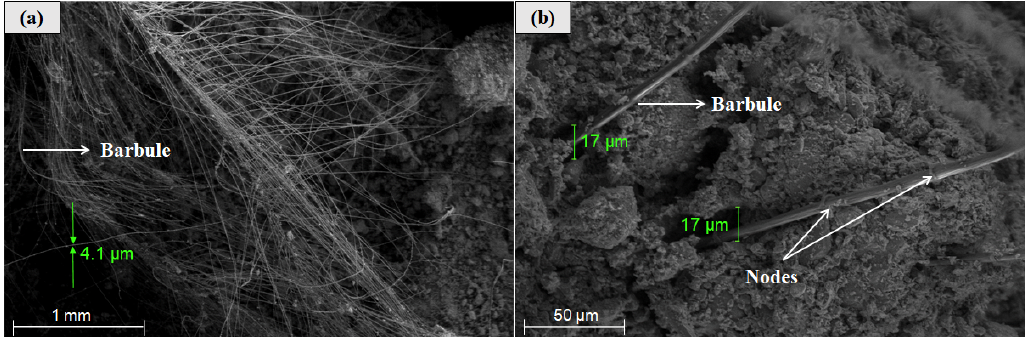
Figure 9. SEM of BPF-reinforced earthen mixes: ( a ) Group of barbules within the earthen matrix and ( b ) interface zone between barbules and the clayey matrix.